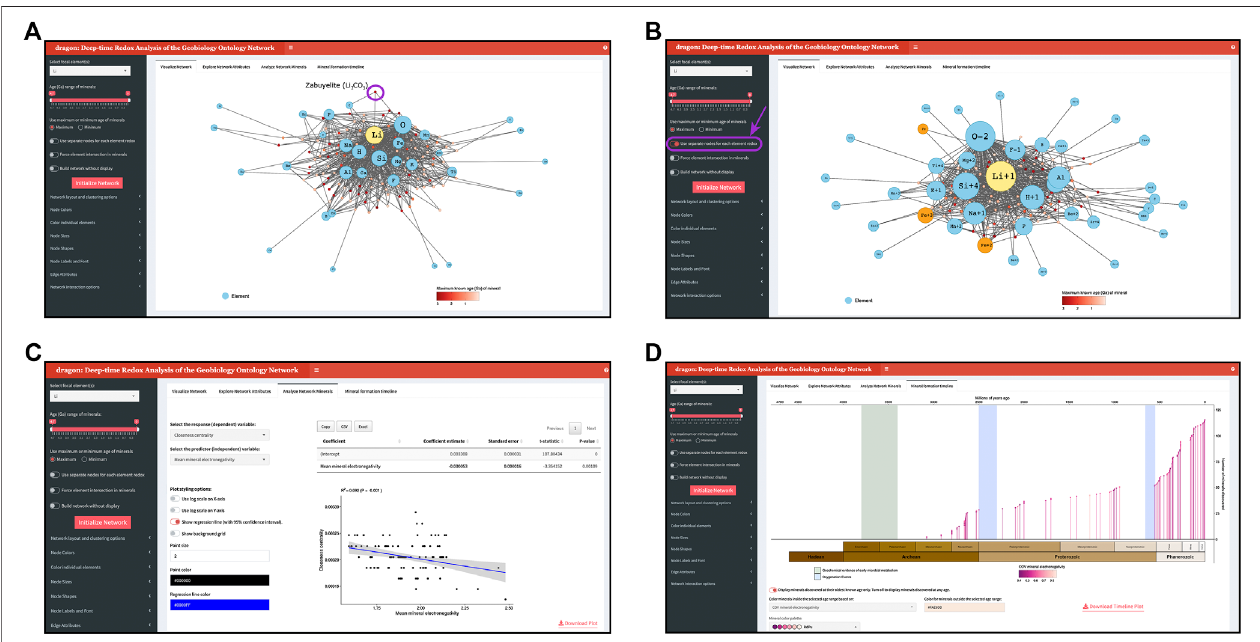
FIGURE 1 | Screenshots of dragon views of the lithium (Li) mineral-chemistry network. Larger labeled nodes represent elements in the network, and smaller unlabelednodesrepresentmineralsinthenetwork. (A) Limineral-chemistrynetworkforallknownLi-containingminerals.Elementnodesareshowninlightblue(withLiin yellow for emphasis), and mineral nodes are colored based on their maximum known age. (B) Li mineral-chemistry network for all known Li-containing minerals, where element nodes are separated based on their redox state. For example, there are now three different nodes for iron (Fe) (colored orange) for each of the Fe redox states present in the network ’ s minerals: Fe 2+ , Fe 3+ , and Fe [representing unknown redox state(s)]. (C) Example of a linear model analysis examining the relationship between mean mineral electronegativity and node closeness centrality for the Li mineral-chemistry network shown in panel ( A ). (D) Mineral formation timeline for all Li- containing minerals, where each line and point represents the oldest-known age of each mineral in the network.